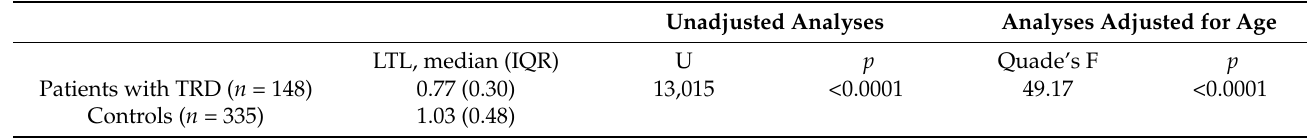
Table 2. Comparison of LTL between patients with TRD and